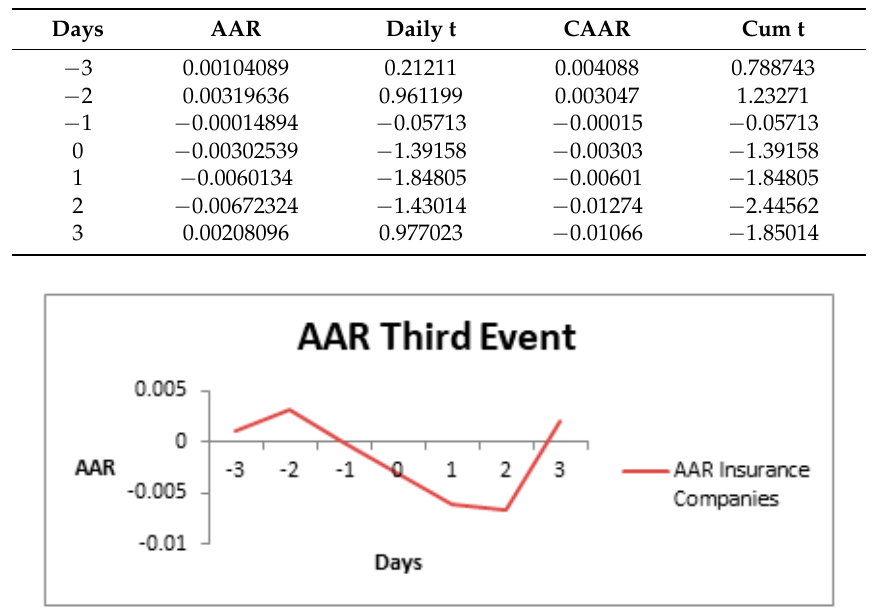
Figure 12. AAR for insurance companies. Source: Authors’ work.